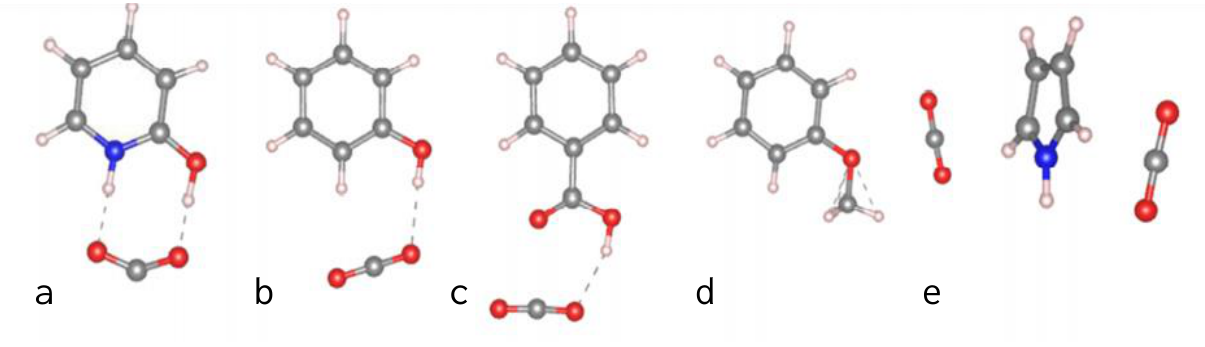
Figure 42. CO 2 interactions with substrates (in the carbonized benzoxazine) containing ( a ) pyridonic nitrogen, ( b ) hydroxy groups, ( c ) carboxylic acids, ( d ) methoxyl, and ( e ) pyrrolic nitrogen, with the effect of hydrogen bonding shown in a–c (reproduced from the work in [108] with permission).